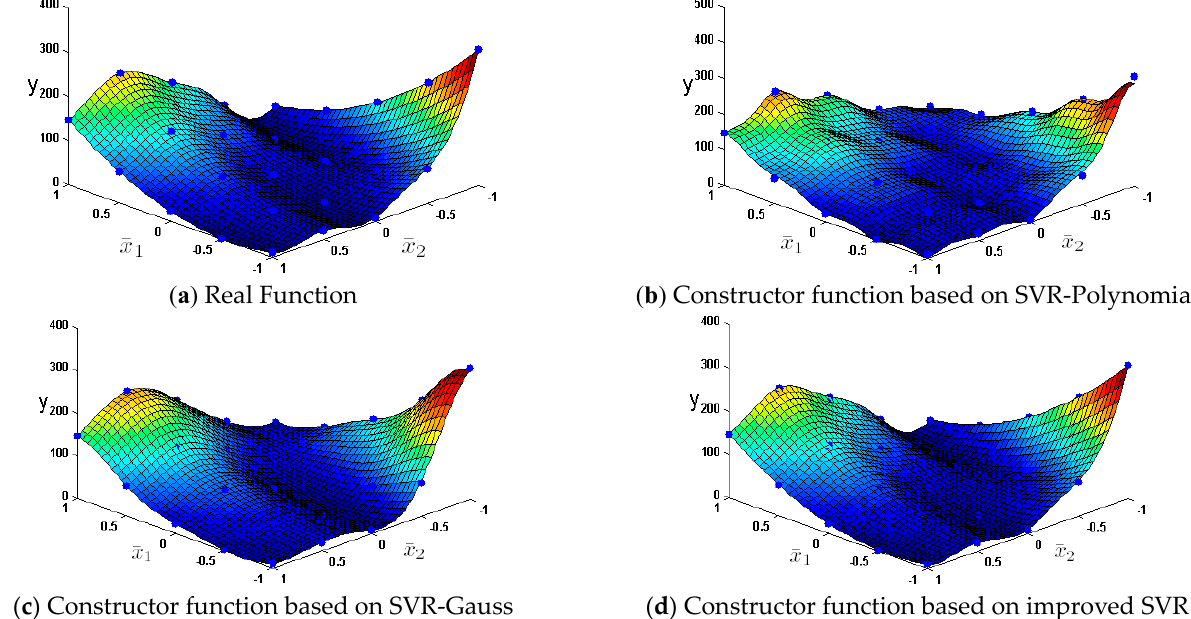
Figure 3. The contraction based on different basis function.